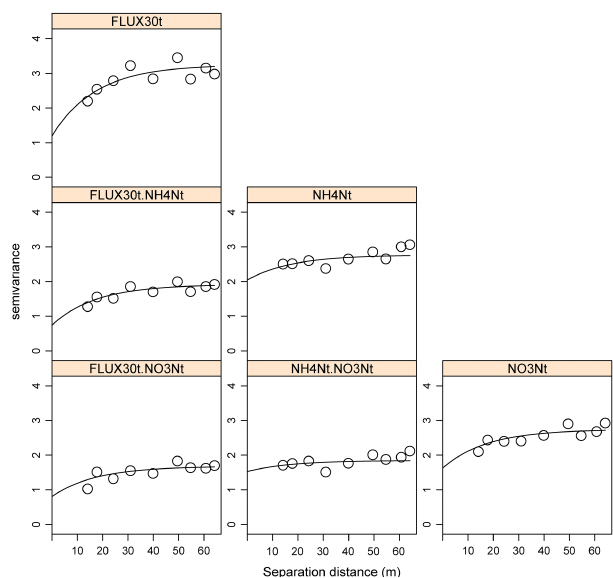
Figure 8. Direct and cross-semivariograms (open circles, detrend- ing the influence of chamber placement position for cokriging) and the best-fit linear model of co-regionalization (solid lines) for the normal logit-transformed N 2 O fluxes (FLUX30t) (no dimension), NH4N (NH4Nt, no dimension) and NO3N (NO3Nt, no dimension). The linear model of co-regionalization was characterized by the same range and different sills for its component